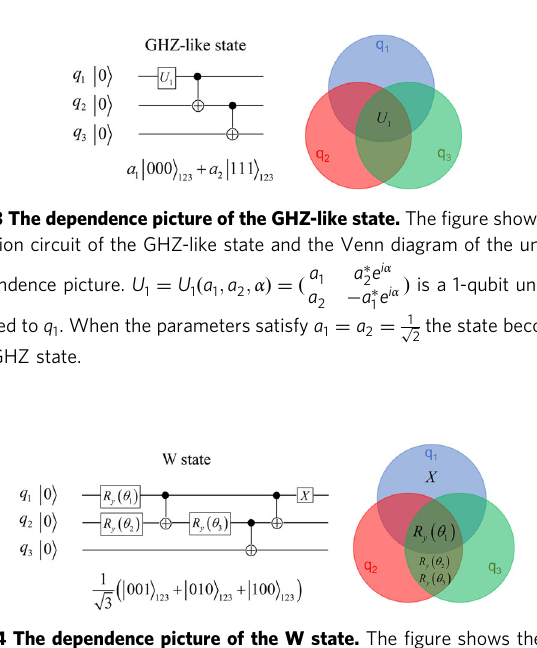
Fig. 4 The dependence picture of the W state. The fi gure shows the creation circuit of the W state and the Venn diagram of the dependence picture. The gates and the parameters are de fi ned as: θ (cid:2) sin θ R θ Þ ¼ ð cos 2 2 Þ , θ 1 ¼ 2arccos ð 1 ffiffi p Þ , θ 2 ¼ (cid:2) θ 3 ¼ π 4 . y ð sin θ cos θ 3 2 2